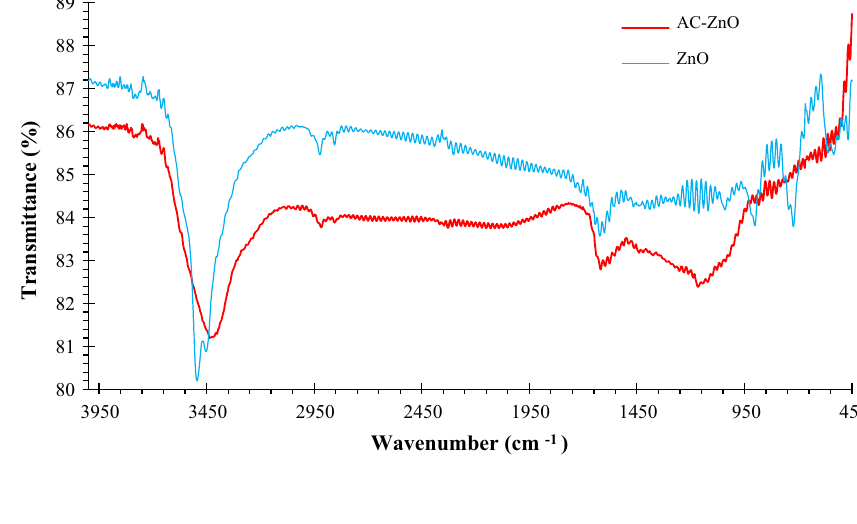
Fig. 2 FTIR spectrum for ZnO